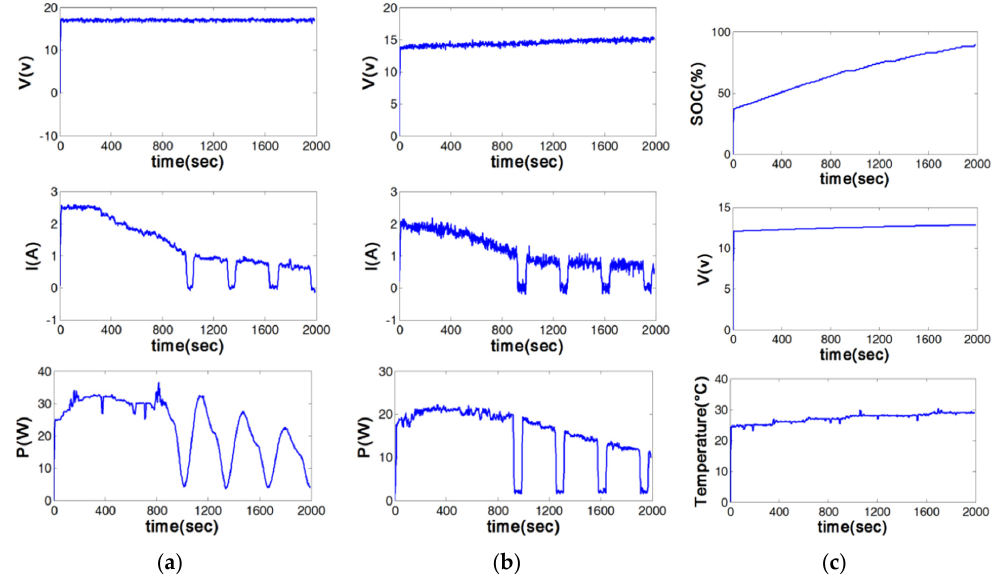
Figure 6. CV-positive pulse charging. ( a ) Power end voltage, current and power curves; ( b ) battery end charging voltage, current and power curves; ( c ) SOC (%), actual voltage and temperature (°C) curves inside battery.